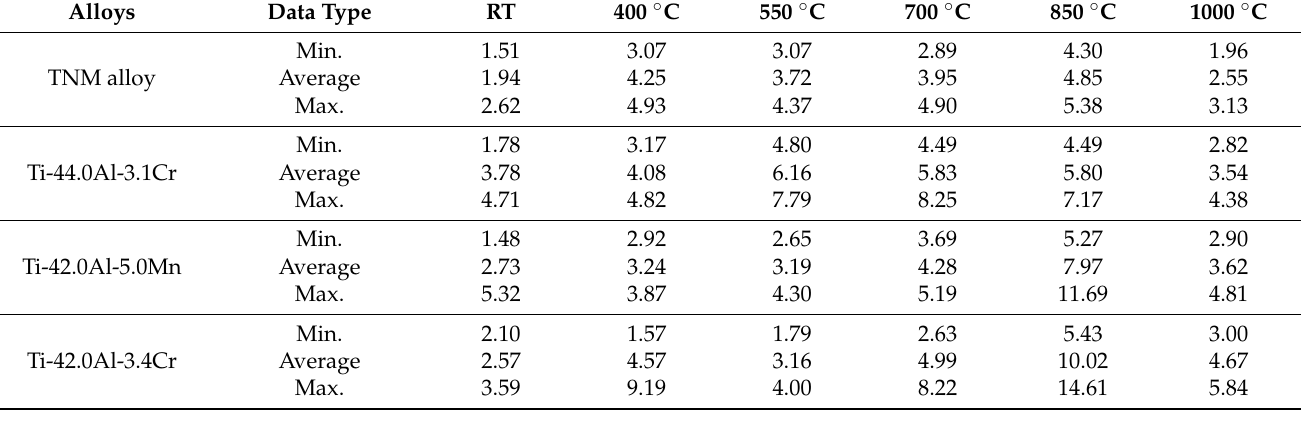
Table 2. Charpy absorbed energies of forged TiAl alloys at various temperatures (J/cm 2 ).